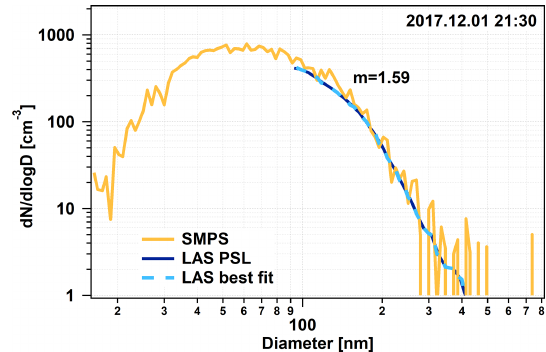
Figure 7. The particle number concentration (green) and the equiv- alent black carbon mass concentration (black) measured on 1 De- cember 2017.